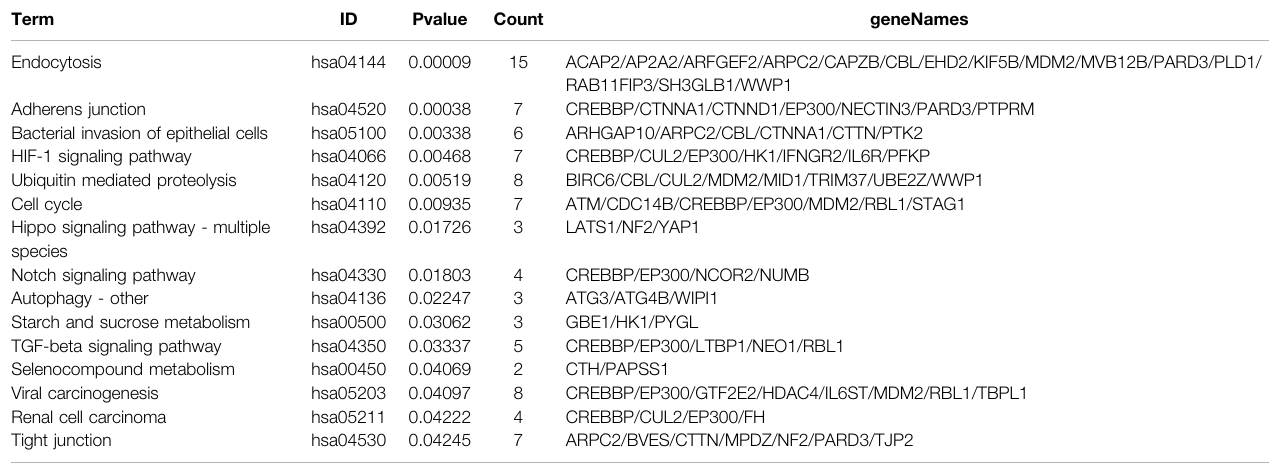
TABLE 2 | The Top 15 Pathways with the Largest Signi fi cant Difference in KEGG Analysis of Parental Genes of DE